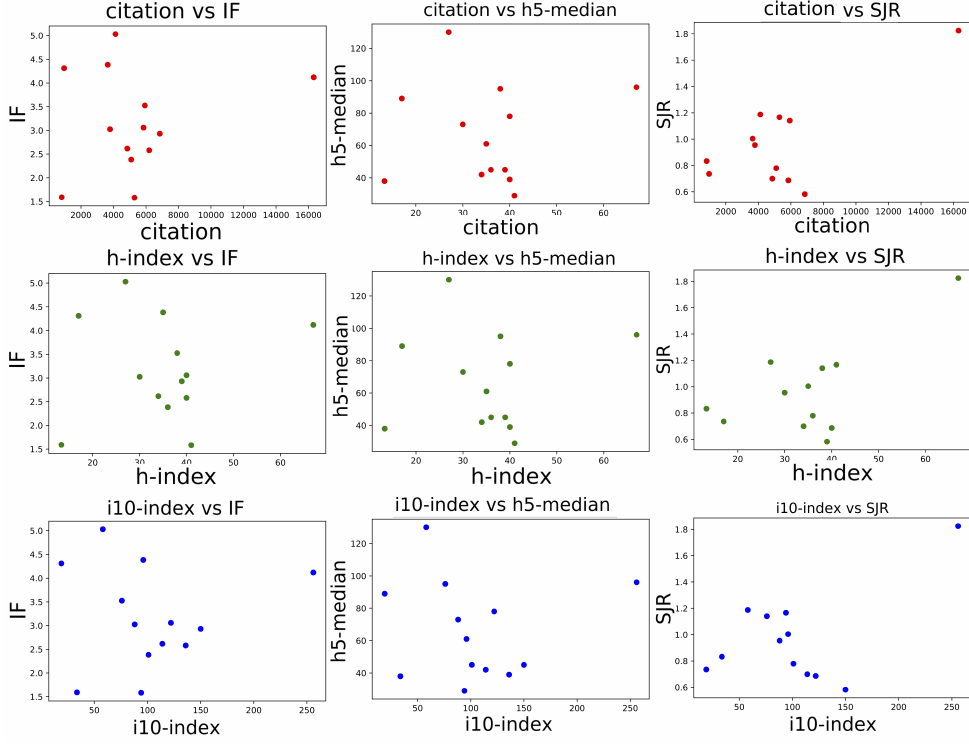
Figure 2. Plots of MI journal’s SJR, IF, and h5-median against various scholarly metrics of